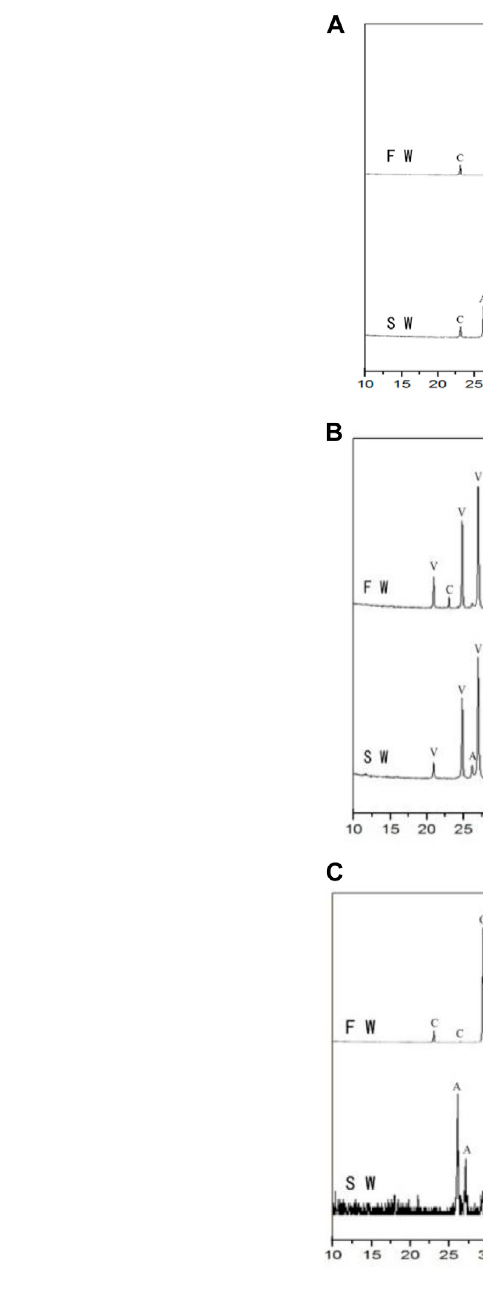
Frontiers in Physics |